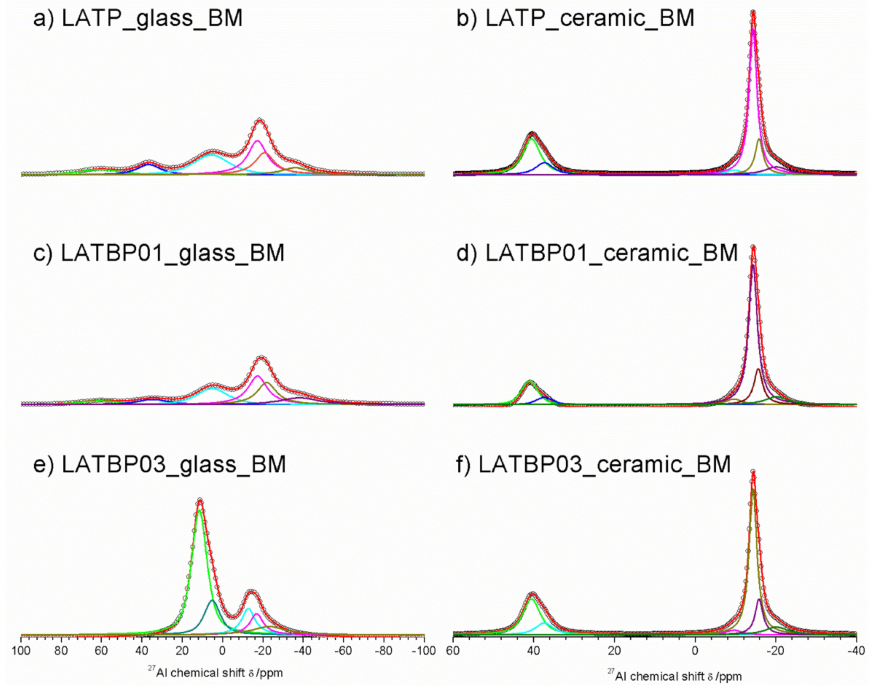
Figure 10. 1D 27 Al MAS NMR spectra of the LAT(B)P_BM series. ( a ) LATP_glass_BM ( b ) LATP_ceramic_BM ( c ) LATBP01_glass_BM ( d ) LATBP01_ceramic_BM ( e ) LATBP03_glass_BM ( f